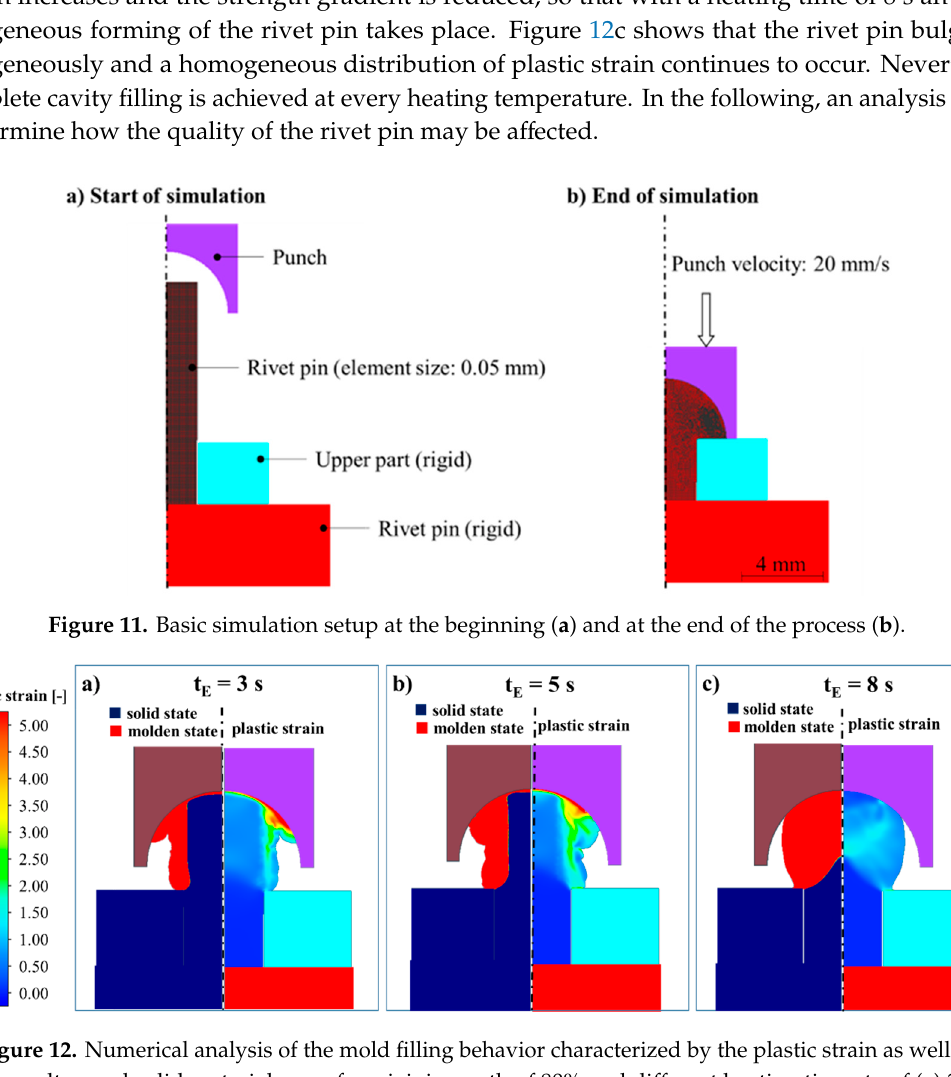
Figure 12. Numerical analysis of the mold filling behavior characterized by the plastic strain as well as the molten and solid material areas for a joining path of 80% and different heating times t E of ( a ) 3 s, ( b ) 5 s and ( c ) 8 s. The contact is analyzed within the numerical simulation to evaluate the formed rivet head quality. If the material contacts itself as a result of the forming process, an emerging weld line is formed. In the worst case, the material contacts itself at too low temperatures and pressures, so that no welding takes place and therefore no material bond prevails in the areas. Figure 13 shows in detail the material flow at a heating time of 3 s as a function of the punch stroke. It can be seen that the self-